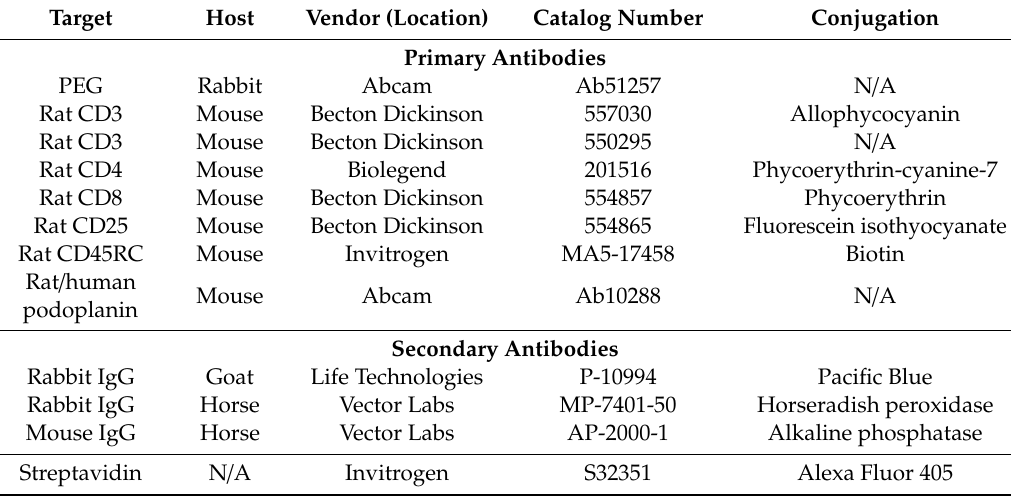
Table 2. Antibodies